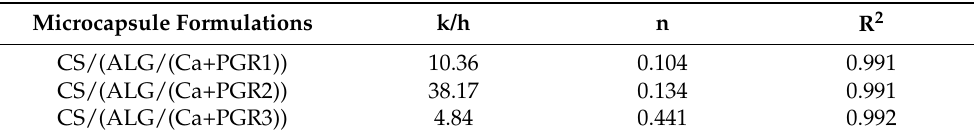
Table 3. Variation of the release constant ( k /h), exponent ( n ) and correlation coefficient (R 2 ) of PGR released from CS/(ALG/(Ca+PGR)) microcapsule formulations. Microcapsule